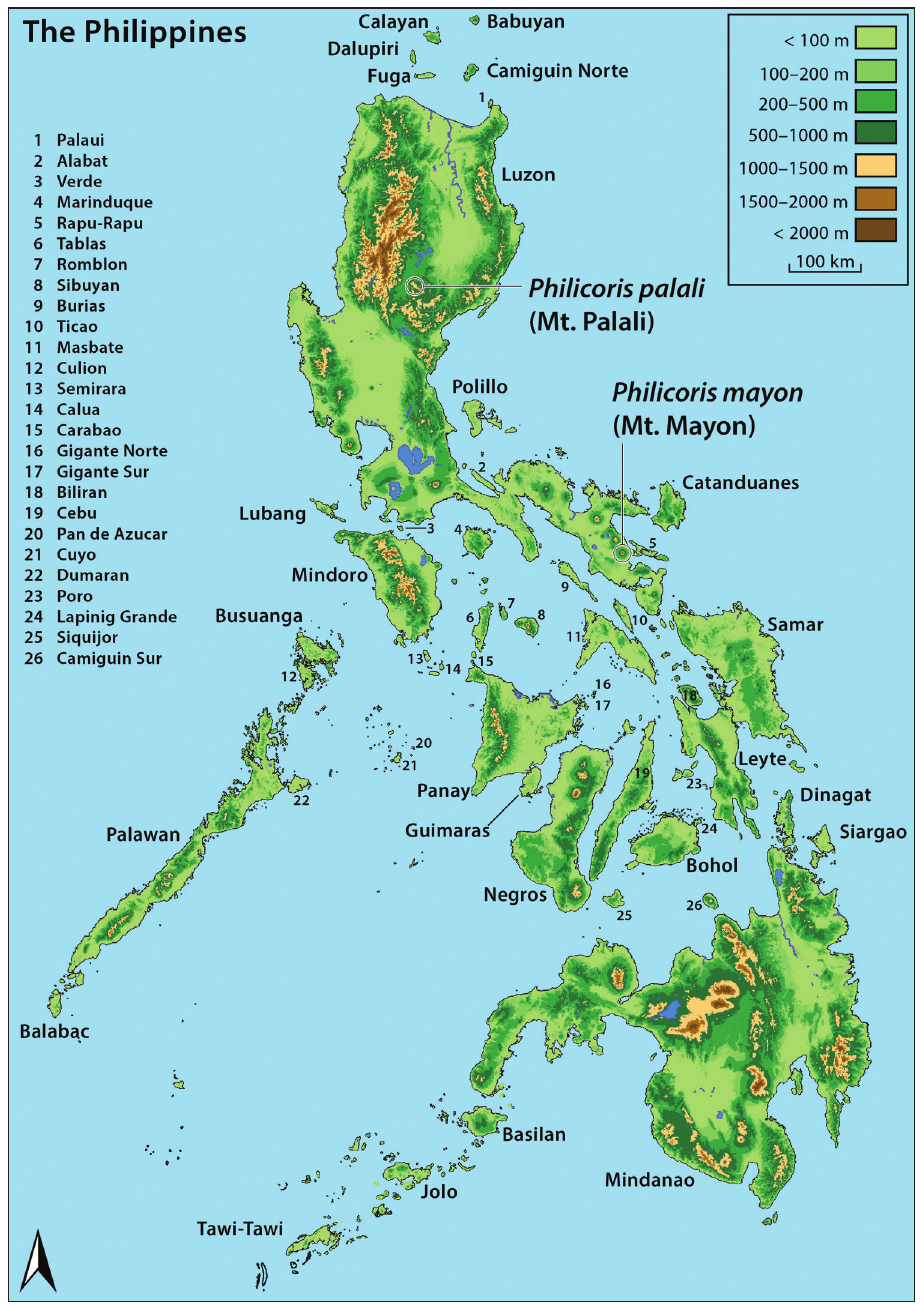
Figure 1. Topographic map of the Philippine archipelago, with island names provided for larger islands. Numeric labels for smaller islands correspond to inset key. Type localities on Luzon Island for Philicoris mayon sp. n. (Mt. Mayon) and Philicoris palali sp. n. (Mt. Palali) shown for